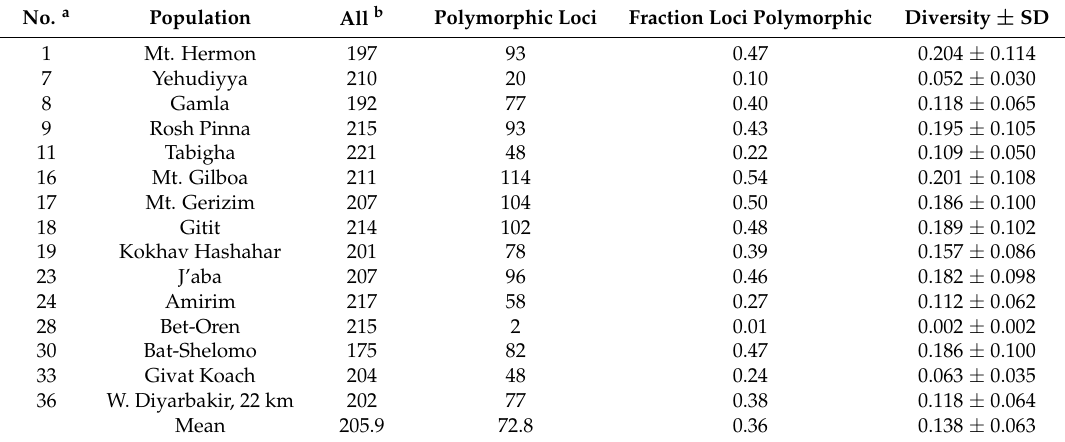
Table 3. Number of polymorphic loci and average gene diversities over the loci.